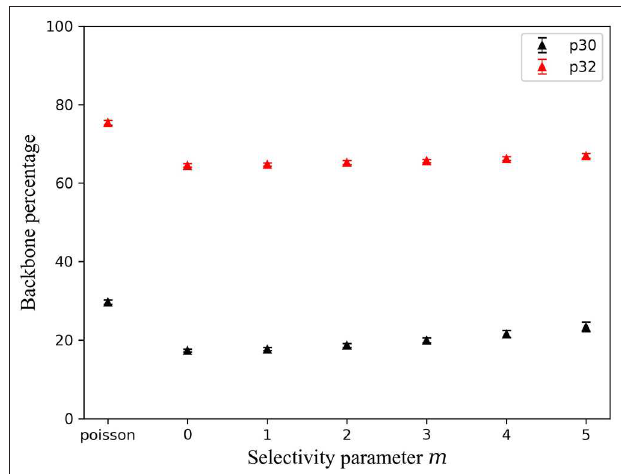
FIGURE 6 | Evolution of backbone percentage with selectivity parameter m ( m = Poisson refers to Poisson